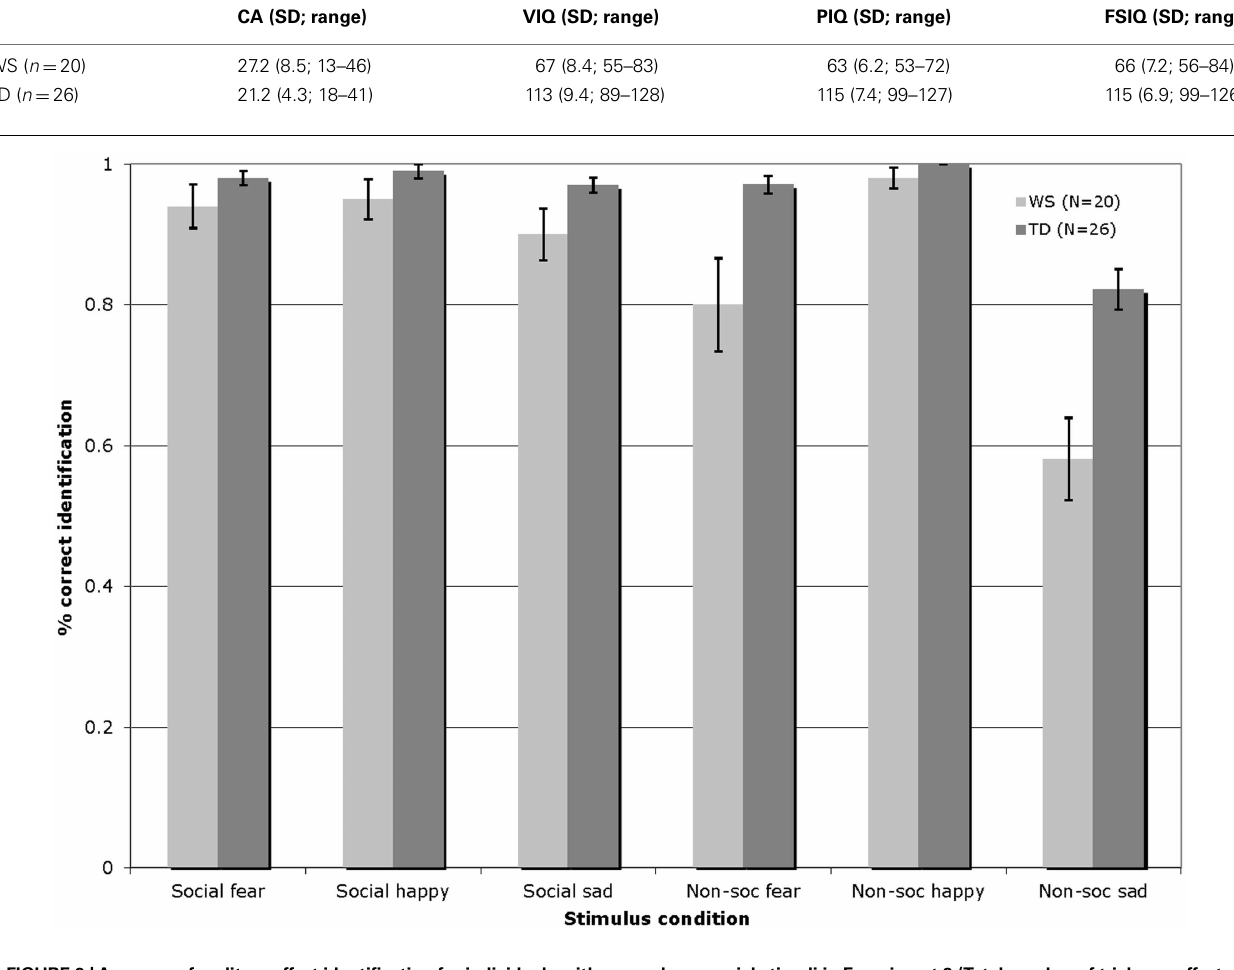
FIGURE 3 |Accuracy of auditory affect identification for individuals with WS andTD, across the happy, fearful, and sad categories for both social